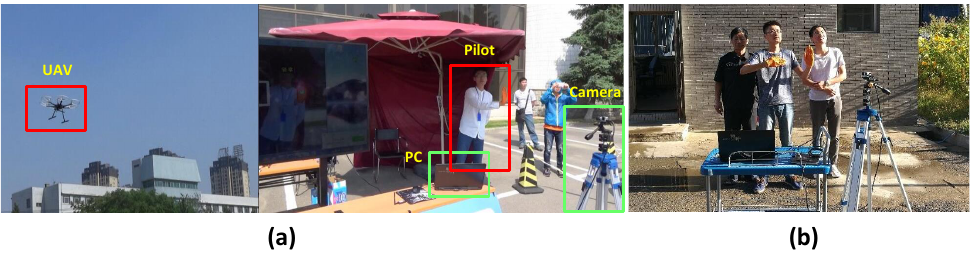
Figure 24. Experimental results of controlling the flight of a real UAV with the proposed system. ( a ) Under the real urban scene; ( b ) Under the strong illumination